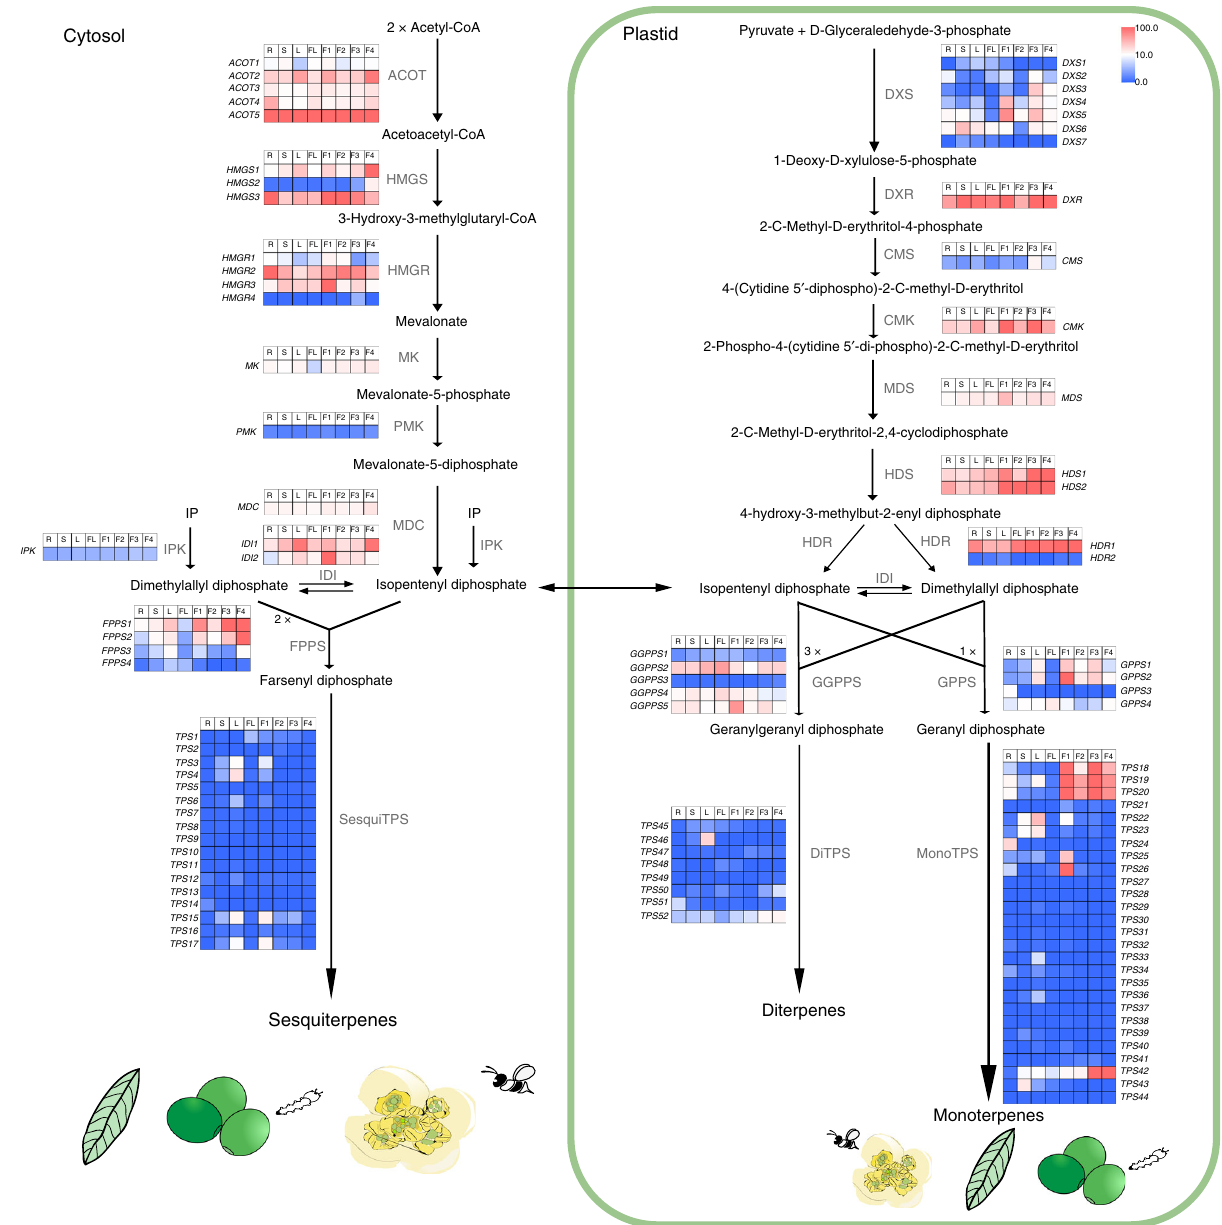
Fig. 4 Scent biosynthesis in Lauraceae. Tissue-speci fi c relative expression pro fi les (red – blue scale) of genes implicated in terpenoid biosynthesis (heat map). Intermediates are shown in black, and the enzymes (Supplementary Table 34) involved at each step are shown in gray. The genes involved in the MEP pathway exhibit a high level of fruit-development-speci fi c expression, which may contribute to the biosynthesis of large amounts of monoterpenes. SesquiTPSs, or the responsible sesquiterpene biosynthesis of fl owers, involve the gene expansion of 17 members (full amino acid length >200 aa). MonoTPSs involved in the production of monoterpenes in fruits also show signs of family expansion for 27 members (full amino acid length >200 aa) of L. cubeba . LcuTPSs form a gene cluster in chromosome 8 (Supplementary Fig. 5). MVA pathway mevalonate pathway, MEP pathway mevalonate-independent (deoxyxylulose phosphate) pathway, R root, S stem, L leaves, FL fl ower, F1 fruit 40 days after full bloom, F2 fruit 70 days after full bloom, F3 fruit 100 days after full bloom, F4 fruit 140 days after full bloom. Source data are provided as a Source Data fi